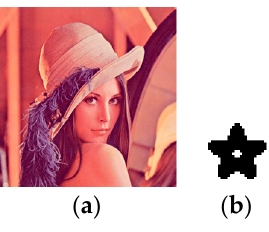
Figure 4. ( a ) Lena Image ( b ) 32 × 32 watermark.